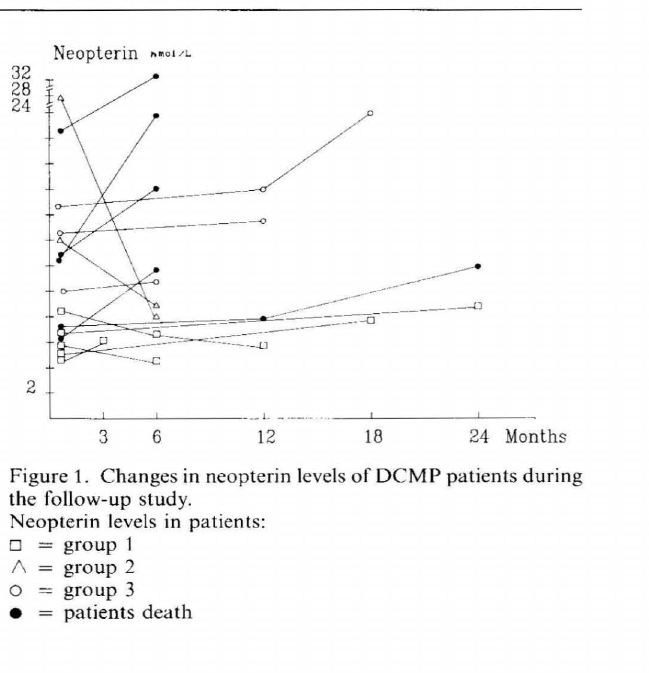
Two patients with high neopterin levels (28 and 14 nmol/L) were included in group 2. The first patient with natural history of DCMP for about a year had an episode of acute bacterial infection at the beginning of our study. His condition improved after specific therapy and signs of acute inflammatory process dis appeared. Another patient had morphologic evidence of myocardial inflammation. In these two patients clinical improvement was associated with decreasing serum neopterin levels.